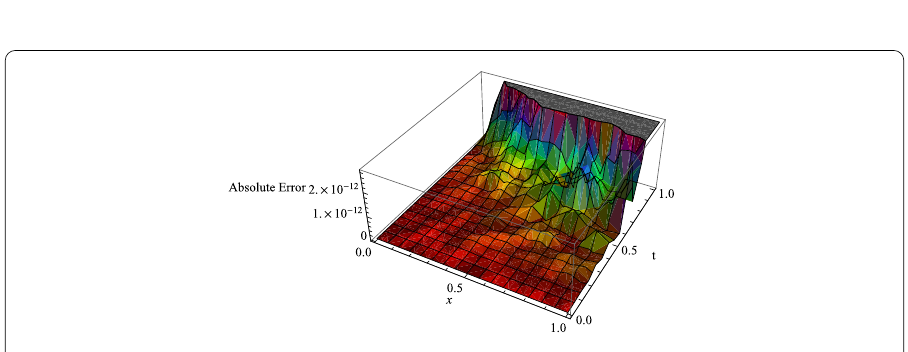
Figure 2 Plot of absolute error E 7 ( w ) = | w ( x , t ) – w 7 ( x , t ) | using HATM when λ = 1